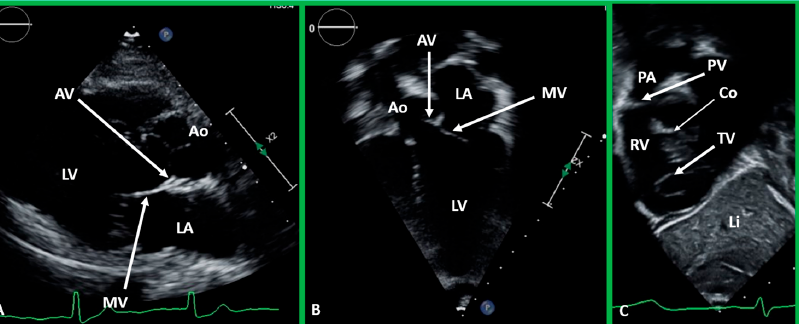
( B ) views to demonstrate the atrioventricular valve-to-semilunar valve relationship. Note that the aortic (AV) and mitral (MV) valve leaflets are in fibrous continuity with each other, indicating that this ventricle is a morphologic left ventricle (LV). ( C ) Selected video frame in a subcostal view to demonstrate atrioventricular valve-to-semilunar valve relationship in a child with normally related great vessels demonstrating lack of continuity between the pulmonary (PV) and tricuspid (TV) valve leaflets due to conus (Co) separating them. Aorta (Ao), left atrium (LA), liver (Li), pulmonary artery (PA), and right ventricle (RV) are